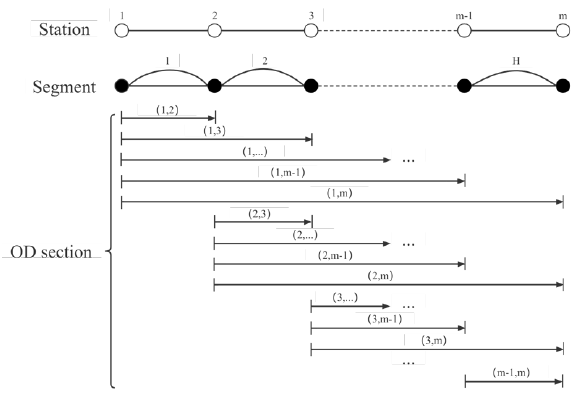
Figure 1. Schematic diagram of passenger s’ ticket-purchasing OD sections.